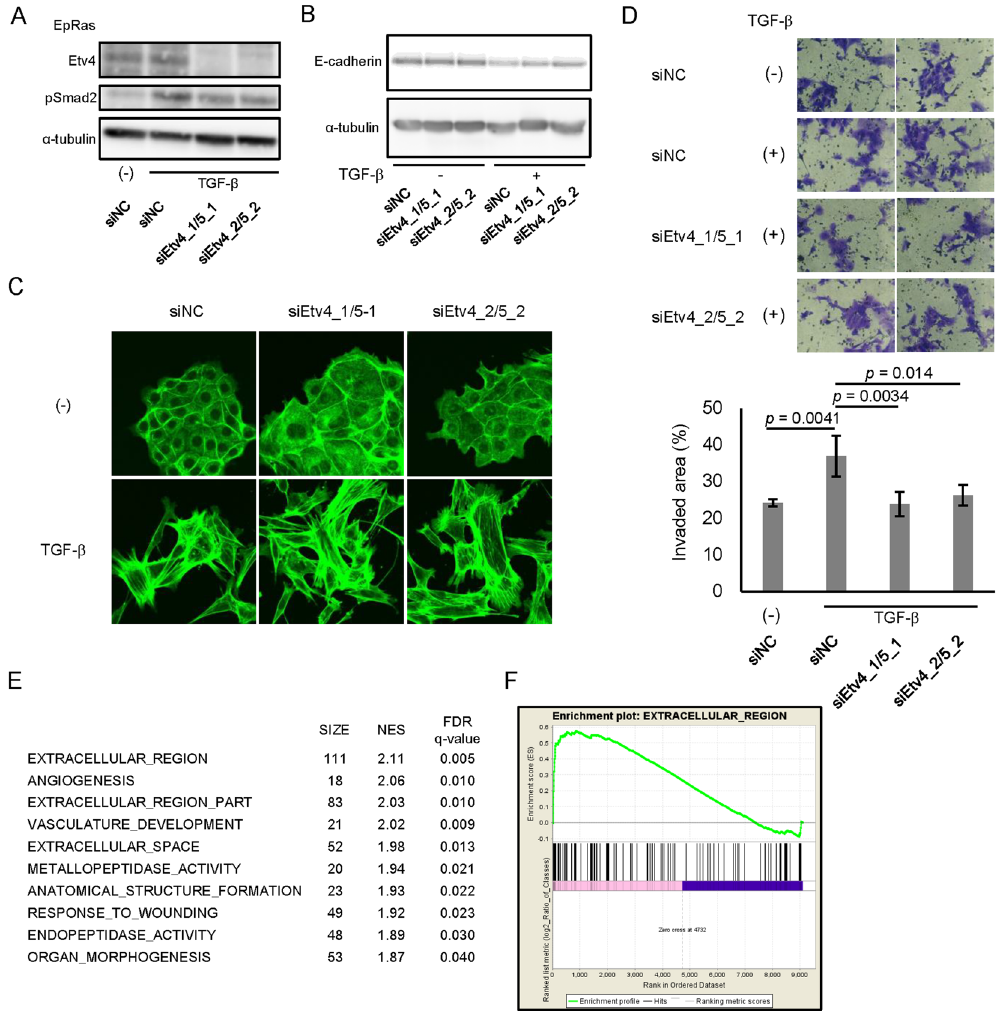
Figure 5. Effect of Etv4 and Etv5 siRNAs on stress fiber formation, cell invasiveness and global gene expression in EpRas cells. ( A ) Effect of the siRNAs on the expression of Etv4 protein. EpRas cells were transfected with the siRNAs as indicated. After 24 h of incubation, cells were treated with TGF- β for additional 48 h and lysed for immunoblotting analysis. ( B ) Effect of Etv4/5 siRNAs on the TGF- β -induced down-regulation of E-cadherin protein. siRNA-transfected cells were treated with TGF- β for 8 days. Transfection of siRNAs were repeated at day 2 and 5. ( C ) Effect of Etv4/5 siRNAs on the stress fiber formation induced by TGF- β . F-actin formation of EpRas cells was evaluated by phalloidin staining. Cells were transfected with siRNAs for Etv4/5 and stimulated with TGF- β for 48 h. ( D ) Matrigel invasion assay in EpRas cells. Cells were transfected with the indicated siRNAs and then seeded on the Matrigel-coated plate, incubated for 48 h with TGF- β , and fixed. (upper panels) Representative images of the cells that migrated through the Matrigel-coated membrane. (bottom graph) Quantified data representing the means of four independent experiments. Error bars, standard deviations. ( E and F ) EpRas cells were transfected with siRNAs for Etv4/5 and treated with 1 ng/ml TGF- β for 48 h. Then, RNA-seq and ontology analysis using GSEA were performed. Genes with maximum FPKM (fragments per kilobase of exon per million mapped sequence reads) values ≥ 5 among the samples were selected for evaluation. ( E ) A list of top-enriched c5 (gene ontology) gene sets (MSigDB) downregulated by siEtv4/5 in the absence of TGF- β . The averaged gene expression data from the two distinct sets of siEtv4/5-transfected cells were compared to the data from the siNC-transfected cells. SIZE: number of genes in the phenotype, NES: normalized enrichment score, FDR: false discovery rate. ( F ) An enrichment plot showing the up-regulation of a gene set “EXTRACELLULAR REGION” by Etv4 and Etv5, which was identified as the top-enriched phenotype by